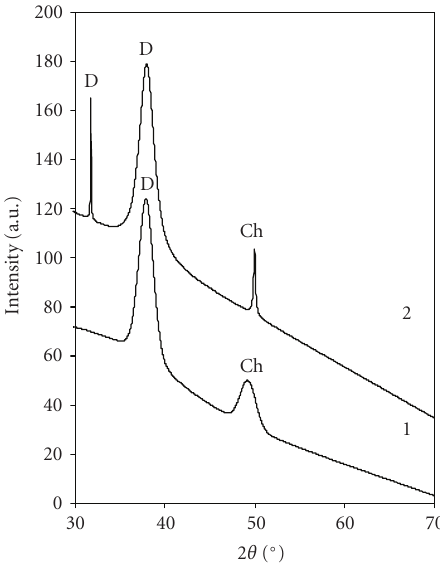
Figure 5: X-ray di ff raction patterns of Cu x S layers on PA 6 (peaks of djurleite — D , chalcocite — Ch ). PA 6 initially pretreated for di ff erent time and then treated with Cu(I) salt solution for 20 minutes at 35 ◦ C. Pretreatment time: 1–4 hours, 2 − 5